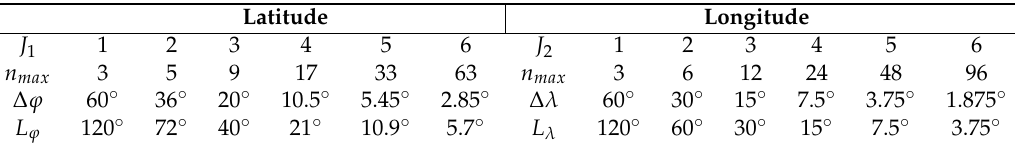
Table 1. Values for the B-spline levels J 1 and J 2 , the maximum spherical harmonics (SH) degree n max , the input data sampling intervals ∆ ϕ and ∆ λ , as well as the minimum wavelengths L ϕ and L λ ; the left part presents the values along the meridian (upper inequalities in Equation (10)), the right part the corresponding values along the equator and its parallels (lower inequalities in Equation (10)). Latitude